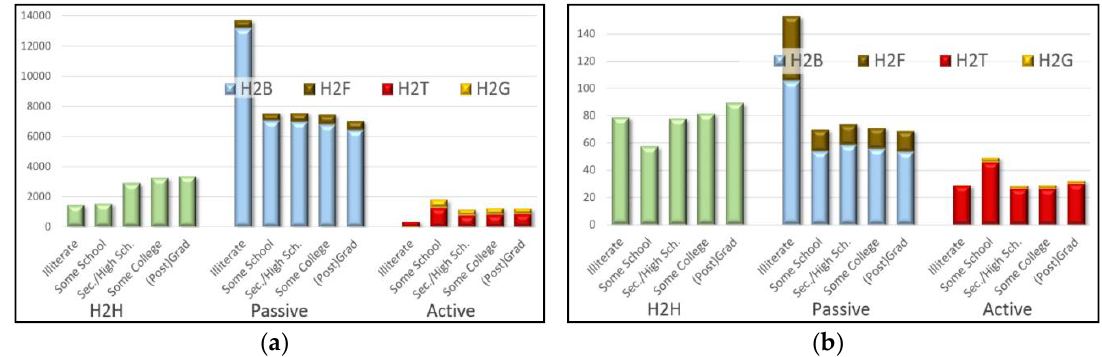
Figure 3. Educational level as fixed factor and six covariates; MANCOVA estimated marginal means of communication type per user per day: ( a ) extensity; ( b ) intensity.